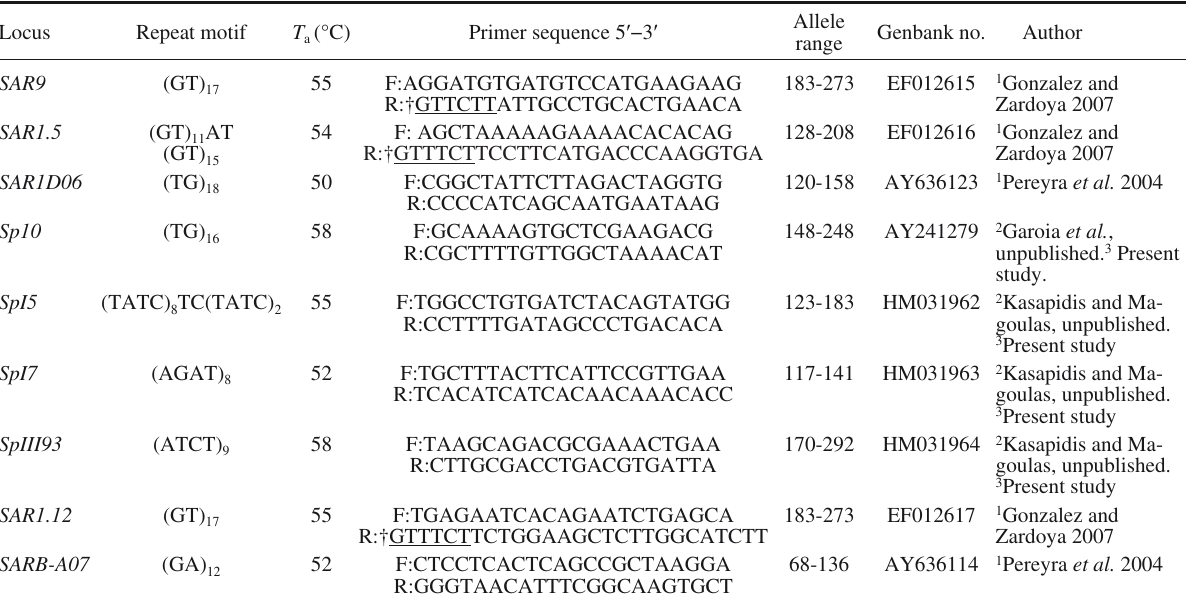
Table 2. – Summary of the loci and the respective primer sequences used in the present study.